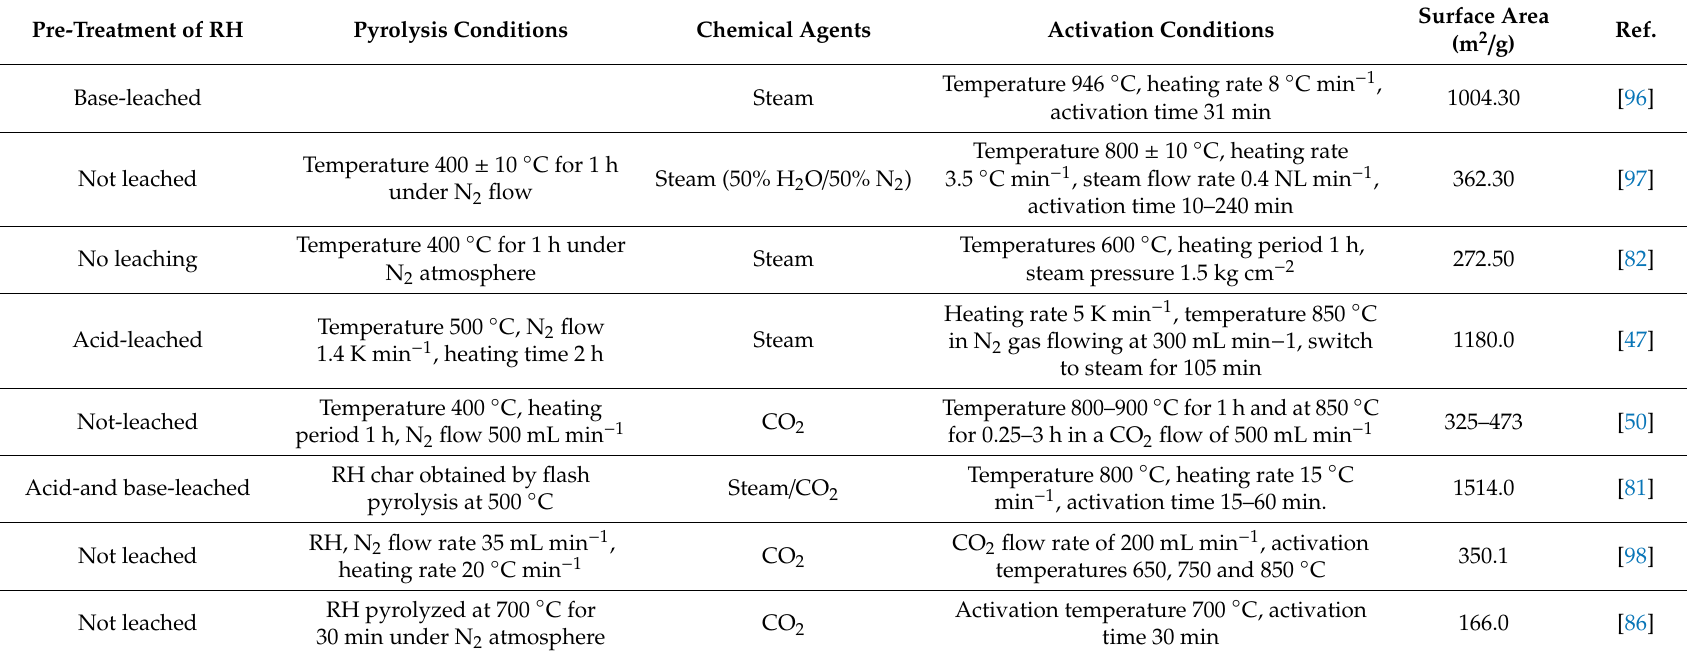
Table 4. Detailed physical activation processes for AC production from